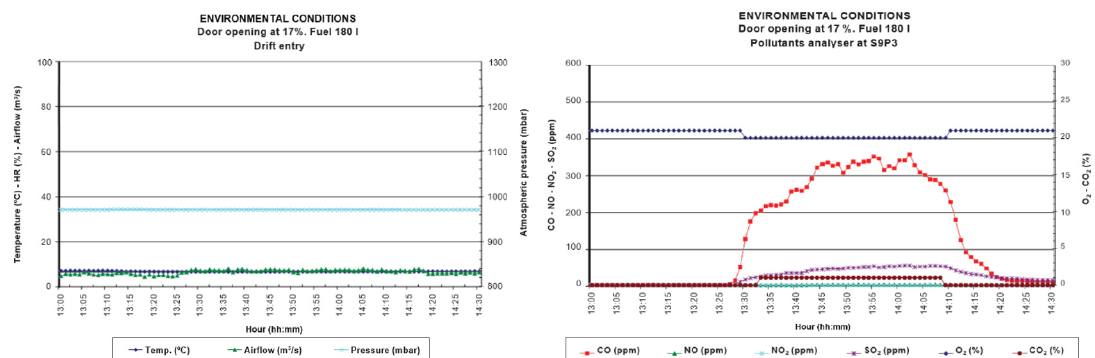
Figure 5. Evolution of the environmental conditions over time; test 1.